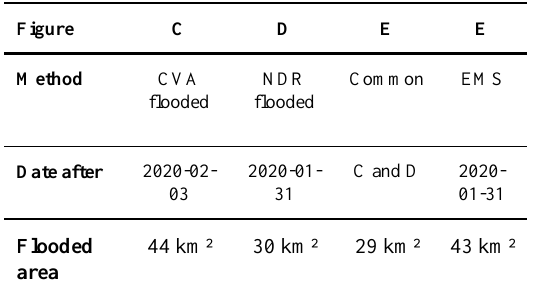
Figure 7. Comparison between Sentinel-2 CVA, Sentinel- 1 NDR and Copernicus products (© OSM contributors, Copernicus Emergency Management Service (© 2020 European Union) ). Table 3. Evolution of the flooded areas in the municipality of Marovay (93